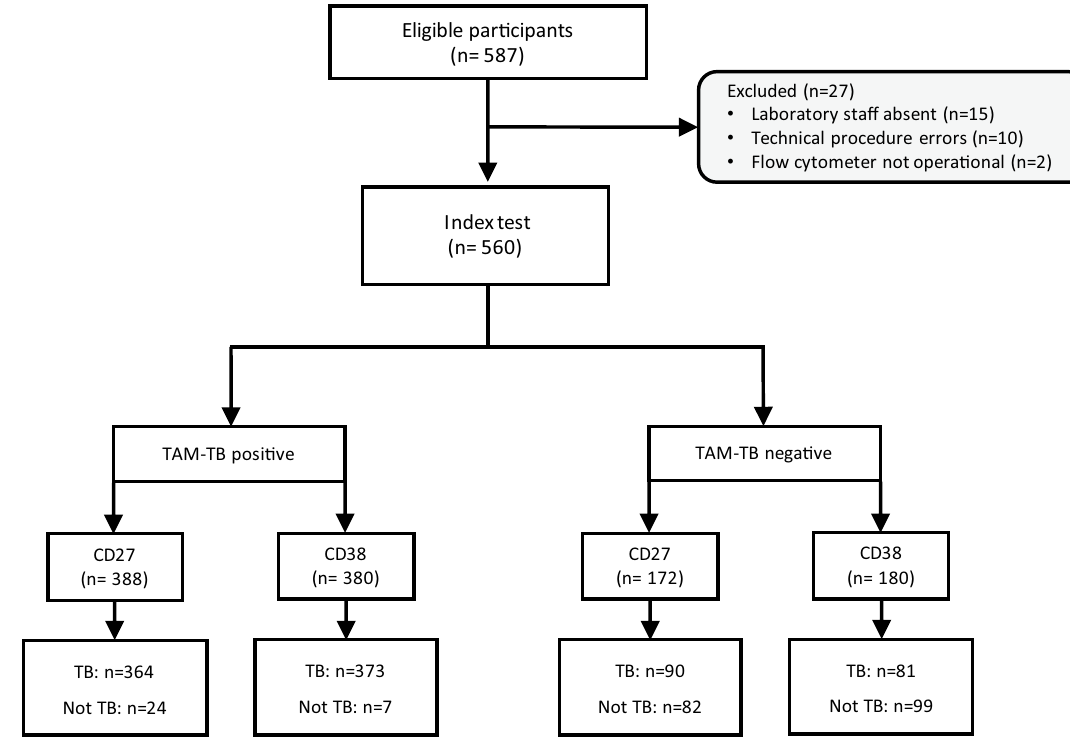
Figure 1. STARD 23 flow chart showing the composition of the initial and the final study populations. TB = Culture + or GenXpert + ; Not TB = Culture – or GenXpert –